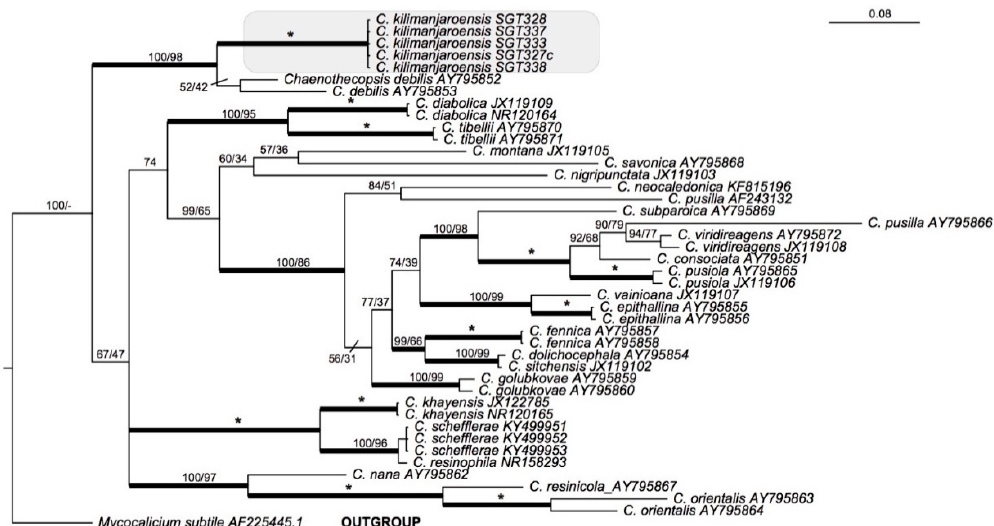
Figure 3. Phylogenetic relationships of 24 species of Chaenothecopsis based on a Bayesian analysis of an ITS dataset. The tree was rooted using Mycocalicium subtile . The two support values associated with each internal branch correspond to posterior probabilities (PP) and maximum likelihood bootstrap support (MLbs) proportions, respectively. Branches in bold indicate a support of PP ≥ 95% and MLbs ≥ 70%. An asterisk on a bold branch indicates that this node has a support of 100% for both support estimates. Chaenothecopsis kilimanjaroensis is highlighted by a shaded box.